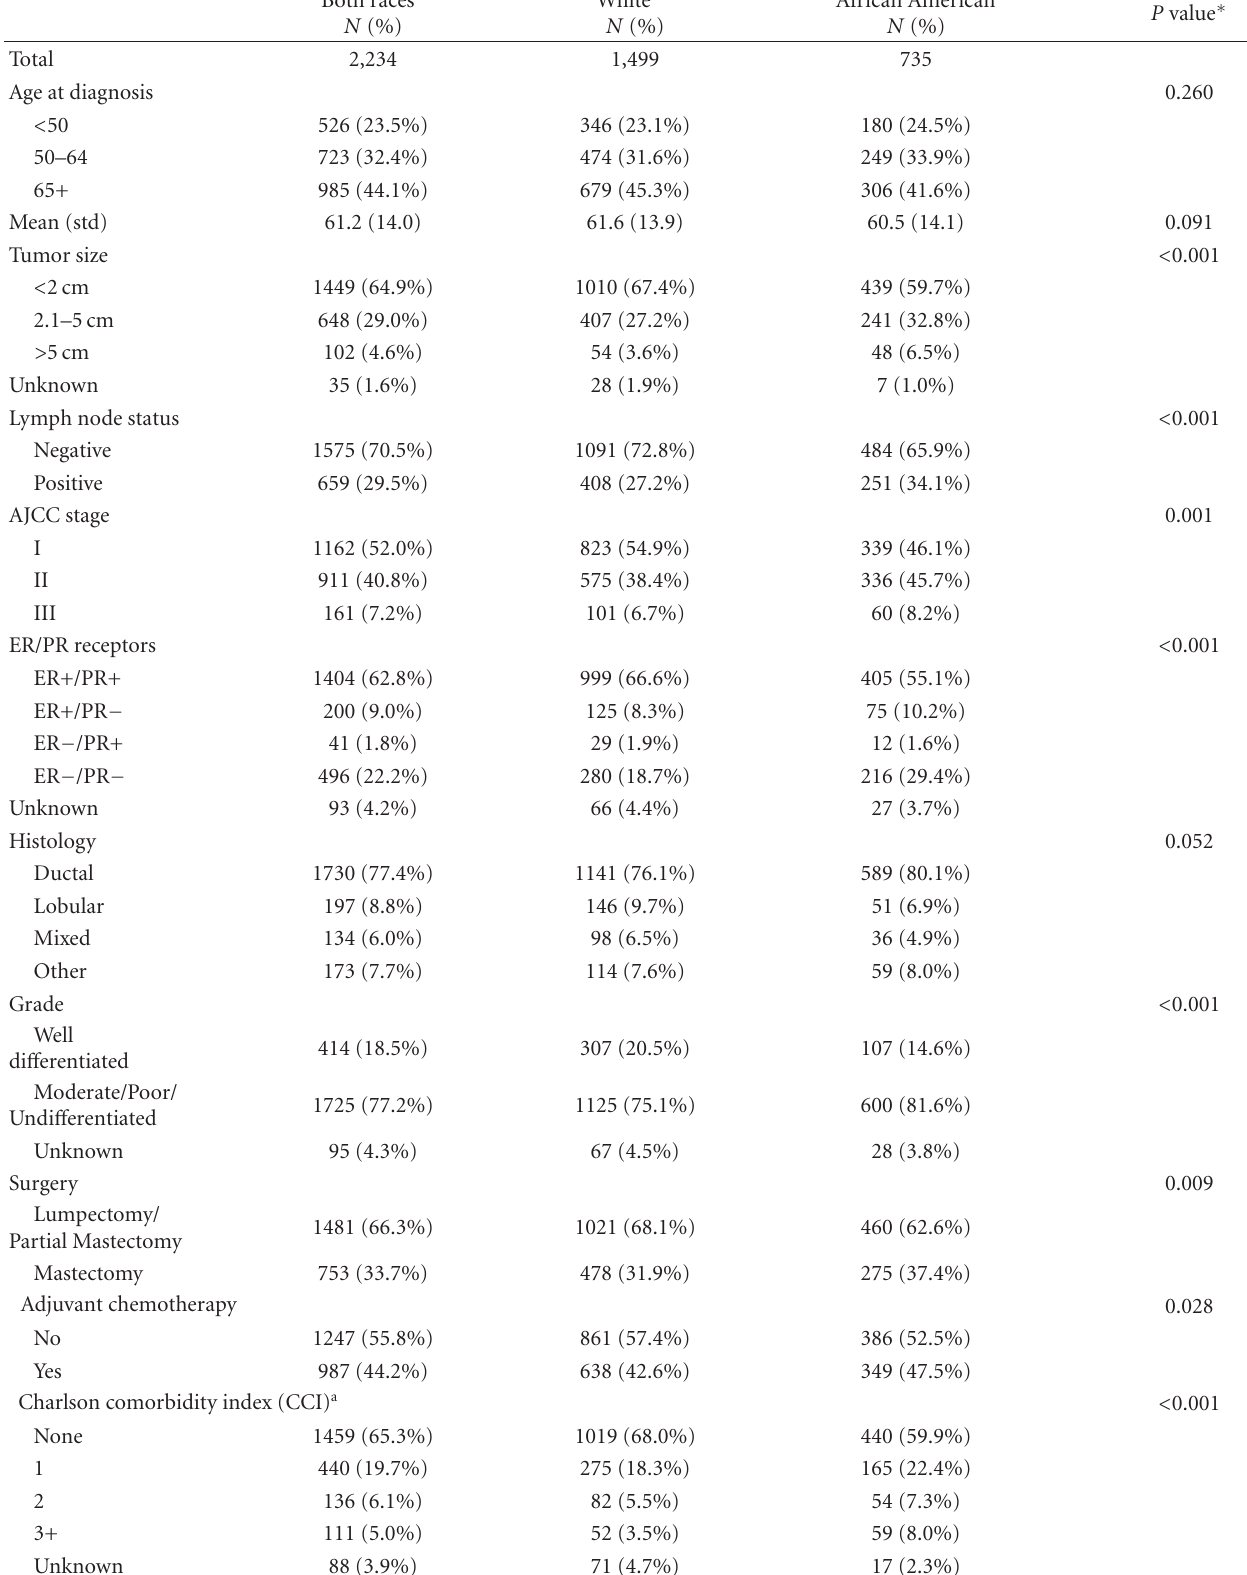
Table 1: Distribution of clinical and sociodemographic features of the HFHS study cohort stratified by